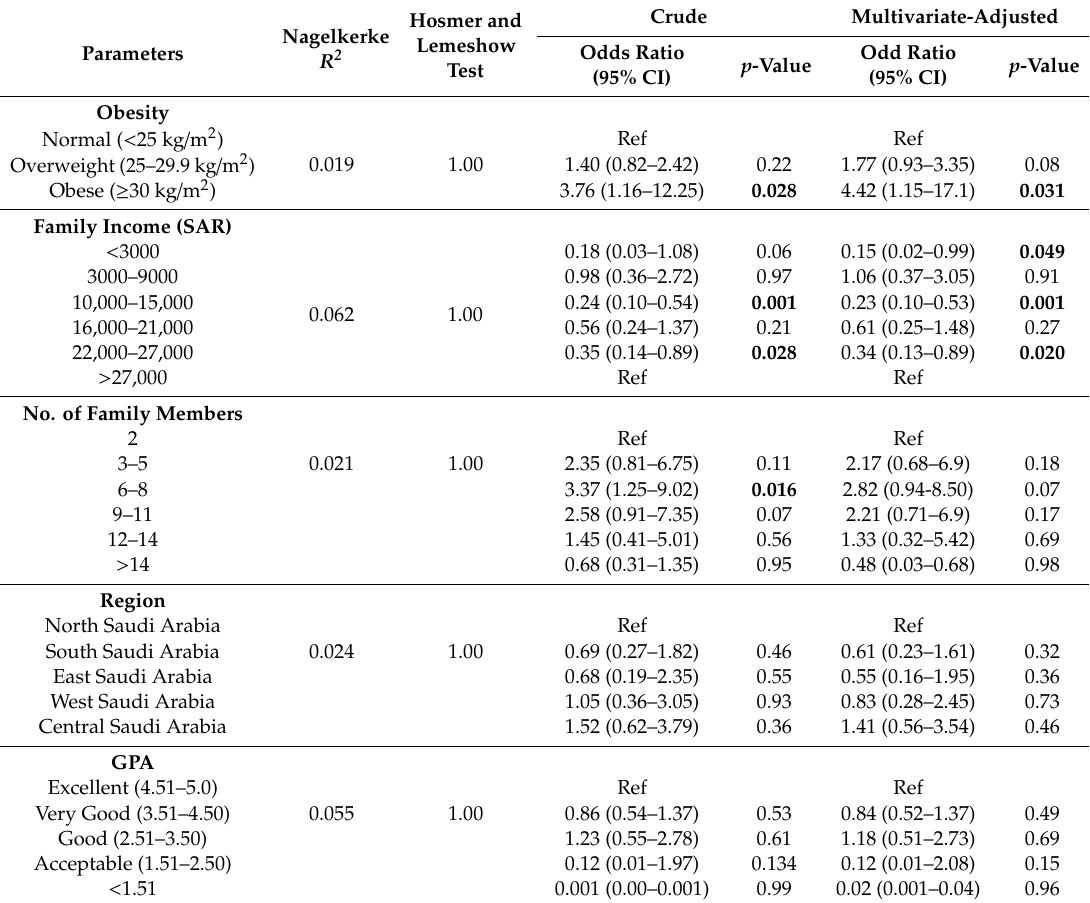
Table 5. Logistic regression model determining independent predictors of co ff ee consumption in Saudi female